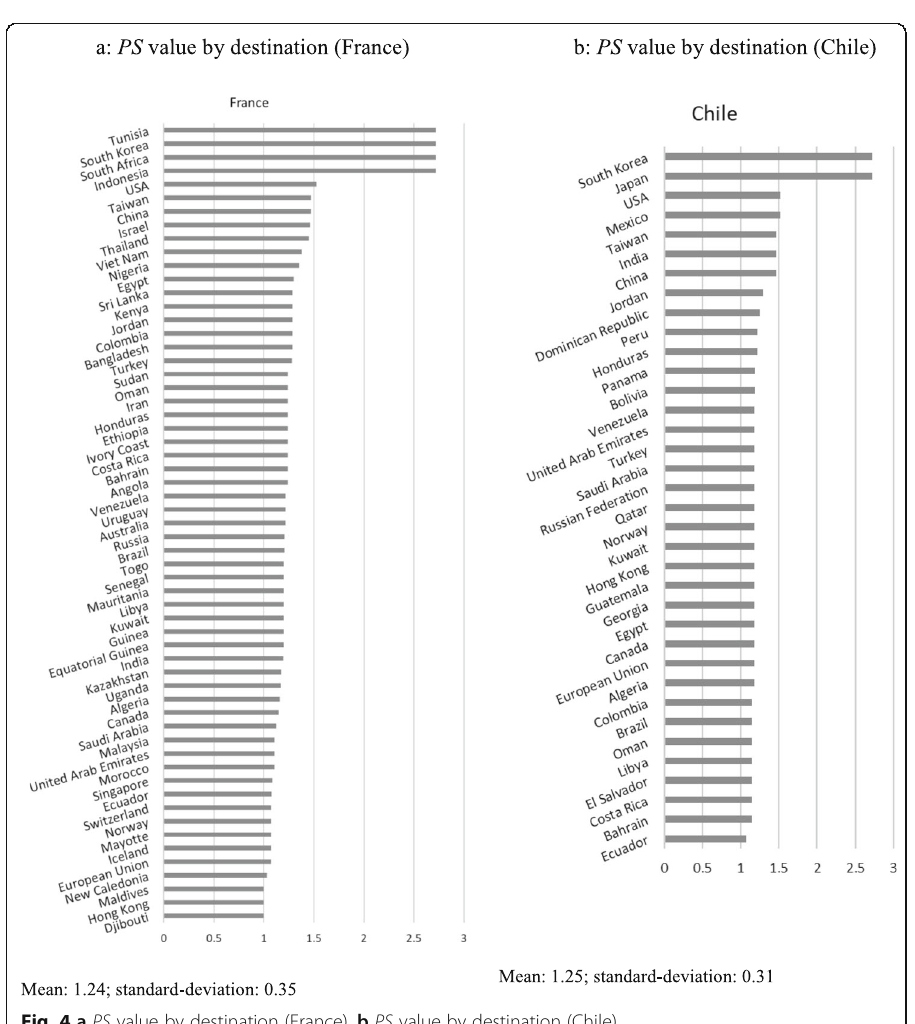
Fig. 4 a PS value by destination (France). b PS value by destination